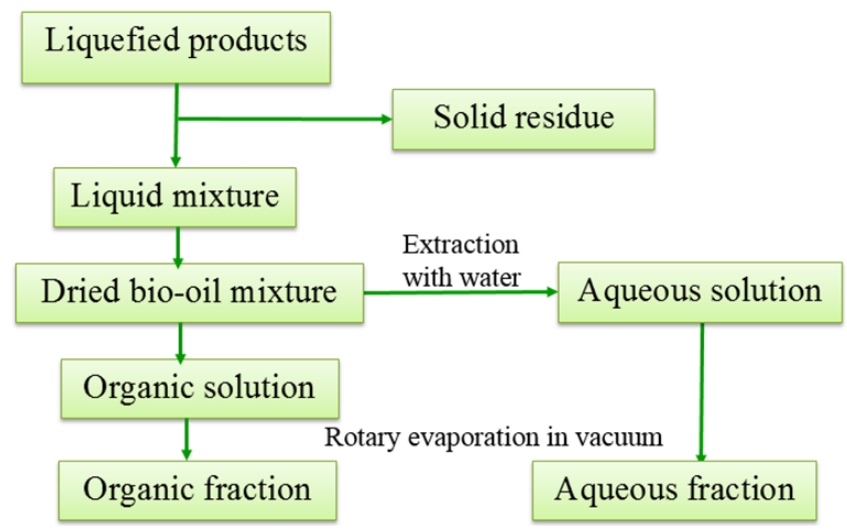
Figure 2. Separation of bio-crude, including aqueous fraction and organic fraction, and solid residues from hydrothermal liquefaction (HTL) product mixture.